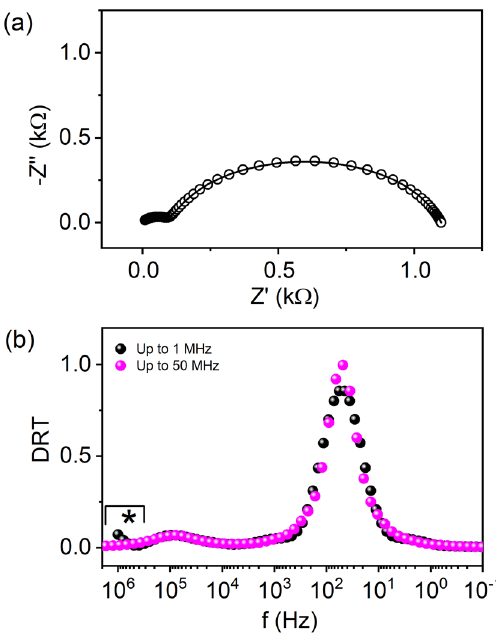
Figure 2. ( a ) Nyquist plots of simulated impedance and ( b ) corresponding DRT for two RC circuits. The solid line is the fit using the code in ( a ). The DRT up to 50 MHz is obtained with an offset of the global corner of 0.001 as shown in ( b